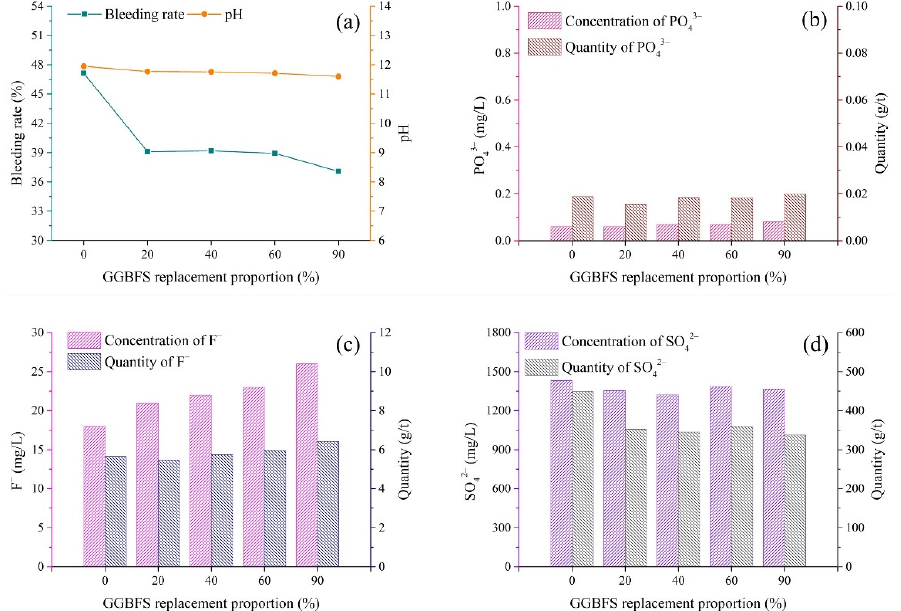
Figure 7. Variations in bleeding rate, pH and pollutants in bleeding water according to GGBFS re ‐ placement proportion. ( a ) Bleeding rate and pH; ( b ) PO 43 − ; ( c ) F − ; ( d ) SO 42 − .